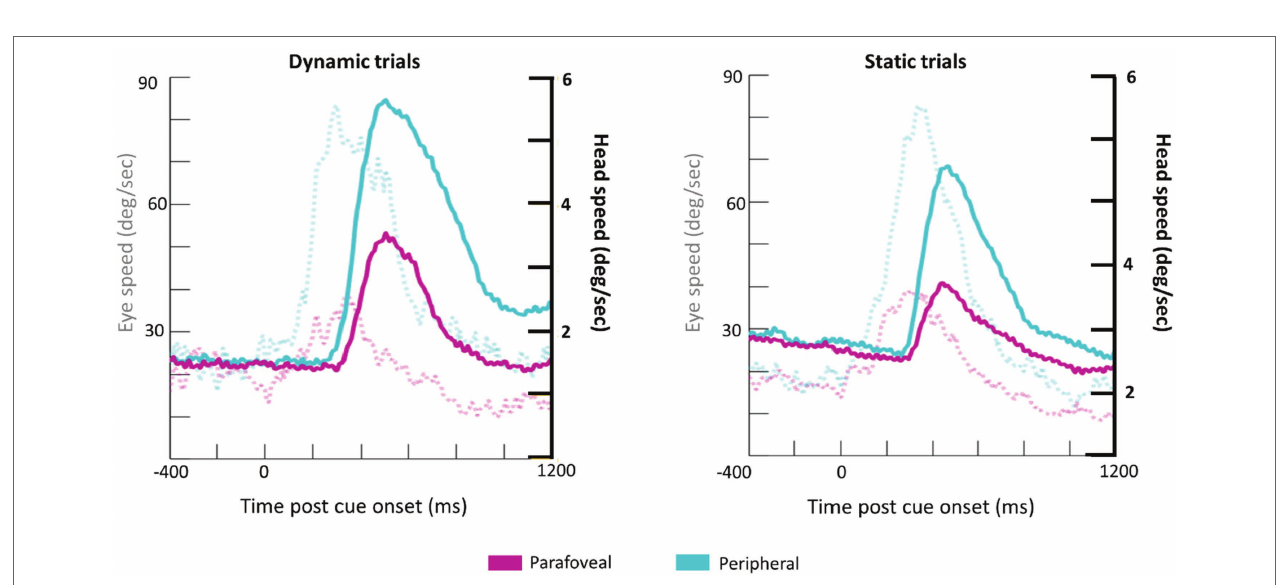
FIGURE 4 | Main sequence scatter plot of saccade amplitude vs. peak amplitude for Dynamic (left) and Static (right) trials. Frequency histograms are plotted on the right y-axis.